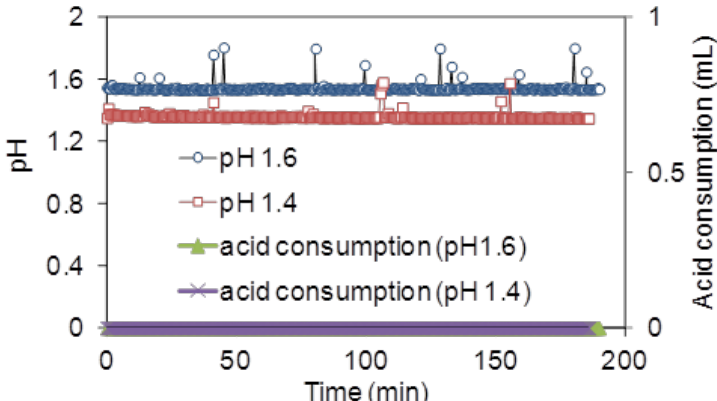
Figure 3. Solution pH and cumulative acid (0.5 M H 2 SO 4 ) consumption of the pyrite ore using 0K medium with 2 g L − 1 ferrous iron at pH values of 1.4 and 1.6 in non-aerated stirred tank reactors without inoculation of cells at 30 °C.